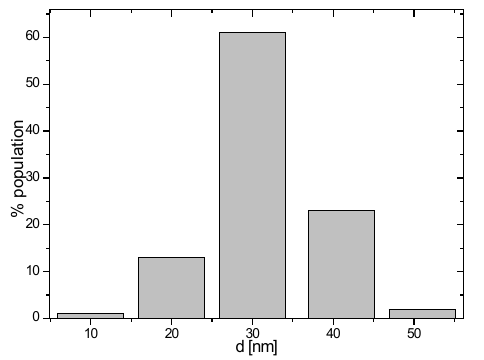
Figure 11. Size percentage distribution of silver nanoparticles resulting from the photoreduction of silver bromide crystals in the presence of ascorbic acid, estimated based on analysis of TEM